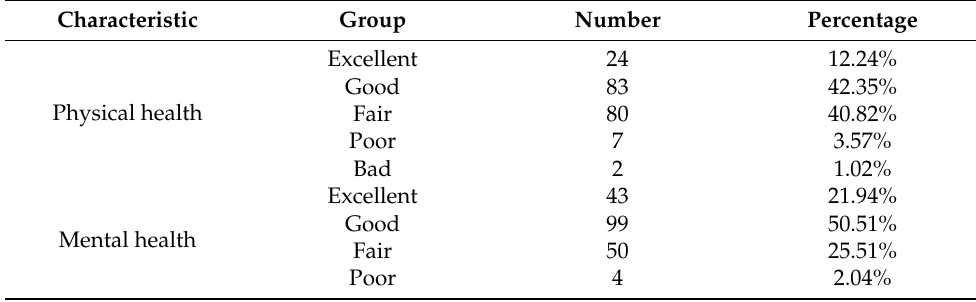
Table 4. Descriptive characteristics of respondents’ mental health and physical